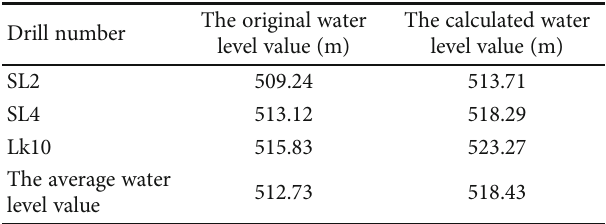
Table 3: The initial data and calculation results of the Majiagou